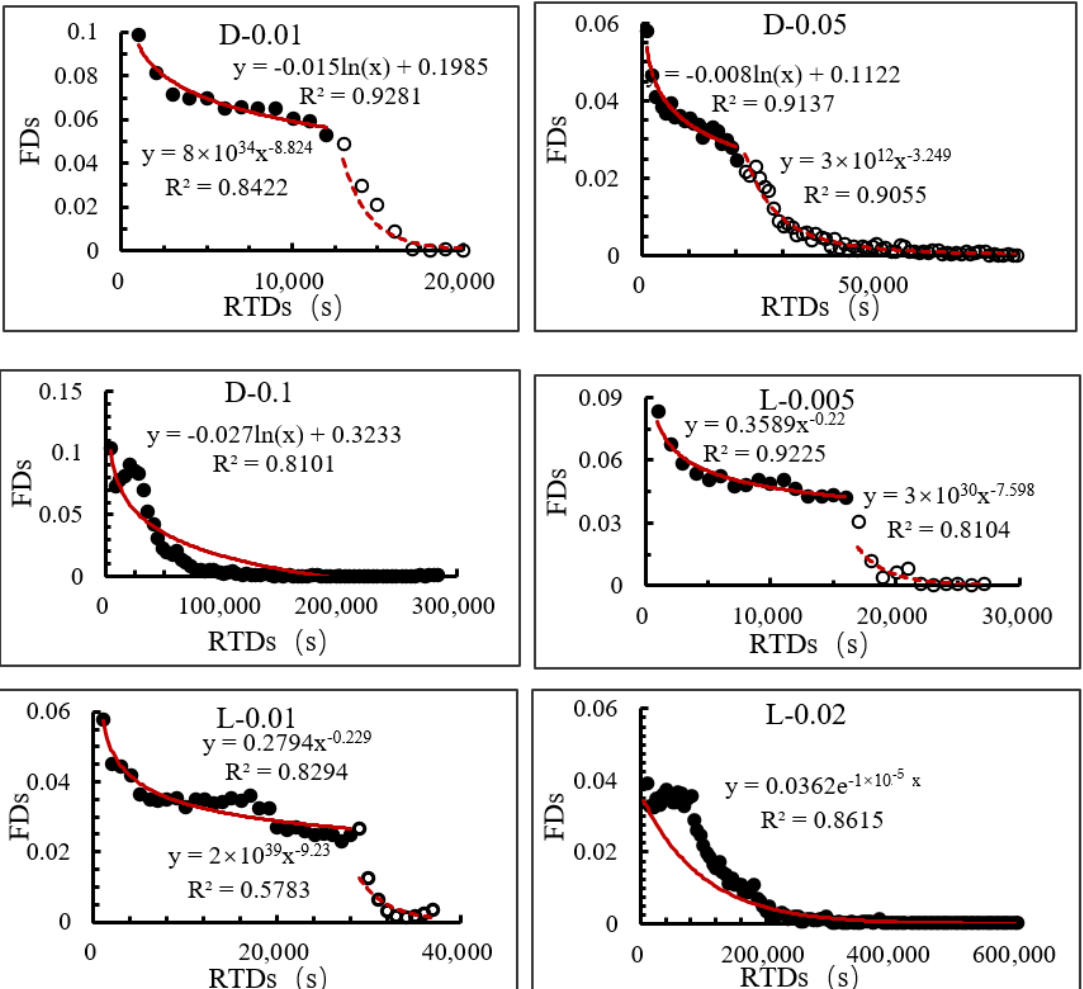
Figure 13. Frequency distribution of RTDs of ambient groundwater with different decay direction and decay exponents of hydraulic conductivity. “D-0.01” means the depth-decay exponent was set to 0.01, and “L-0.005” means the length-decay exponent was set to 0.005. The red lines are fitted trend lines.